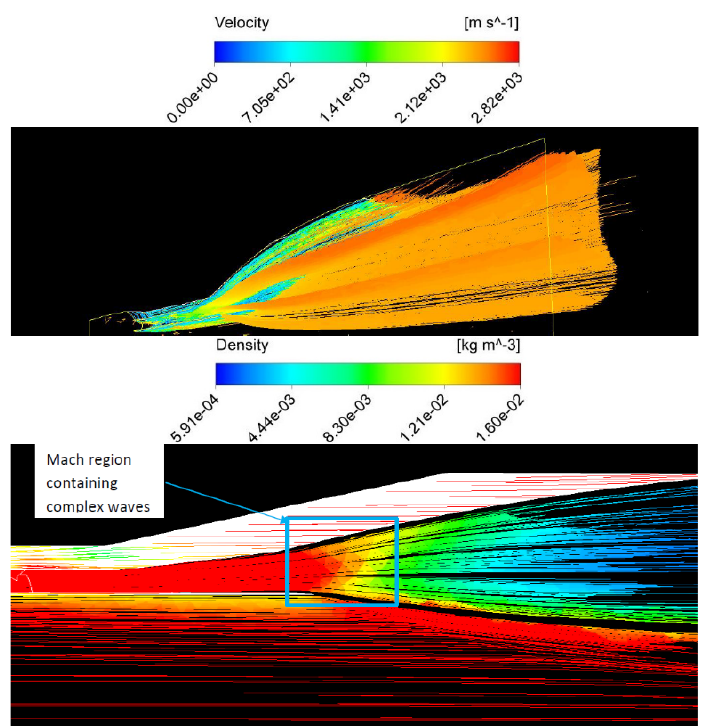
Figure 27. Velocity and density streamlines of the scramjet engine.